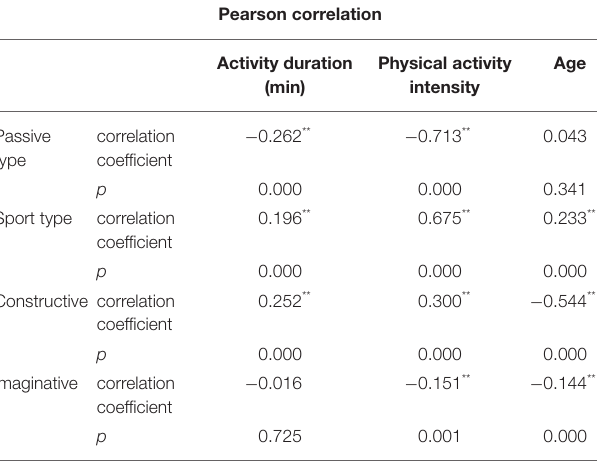
TABLE 8 | Correlation analysis of children’s activity